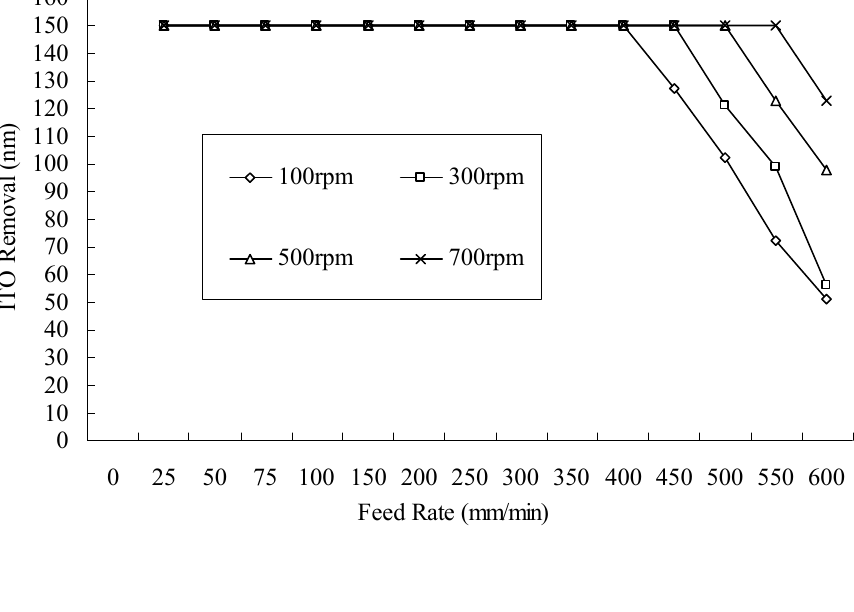
Figure 8. Amount removed at different rotational speeds of the negative-electrode (NaNO of 10 wt% and PO4-3-P 5 wt%, 55 °C, 150 A, continuous